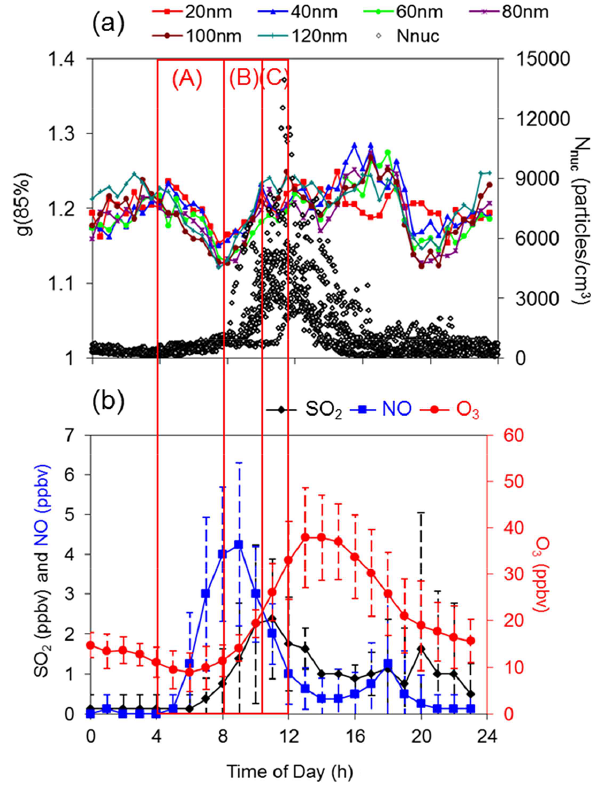
Figure 4. Diel variations in (a) median g (85%) values in the dry D p range of 20–120nm with a 20nm increment and N nuc , and (b) SO 2 , NO, and O 3 concentrations during the NPF events. g (85%) at dry D p =20, 40, 60, and 80nm were converted to equivalent g (85%) of dry D p =100nm by considering the Kelvin effect. Error bars in (b) represent standard deviations (1 σ ) of SO 2 , NO, and O 3 concen-